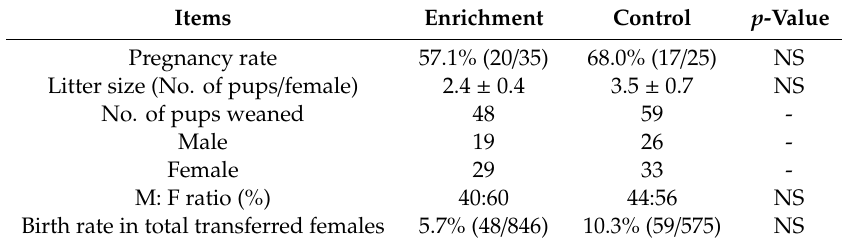
Table 2. Reproductive outcomes of Swiss Webster females used as recipients for embryo transfer. Items Enrichment